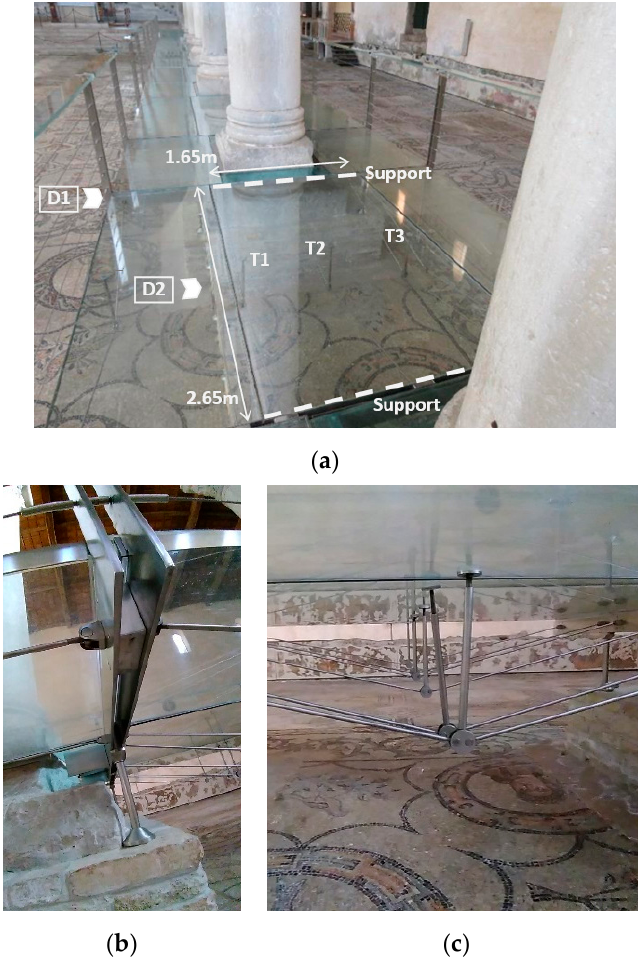
Figure 6. Reference two-side supported panel along the central nave path: ( a ) General view, with ( b )–( c ) D1 and D2 details (reproduced from [20] with permission from Elsevier, license n. 4585290441718, May 2019).